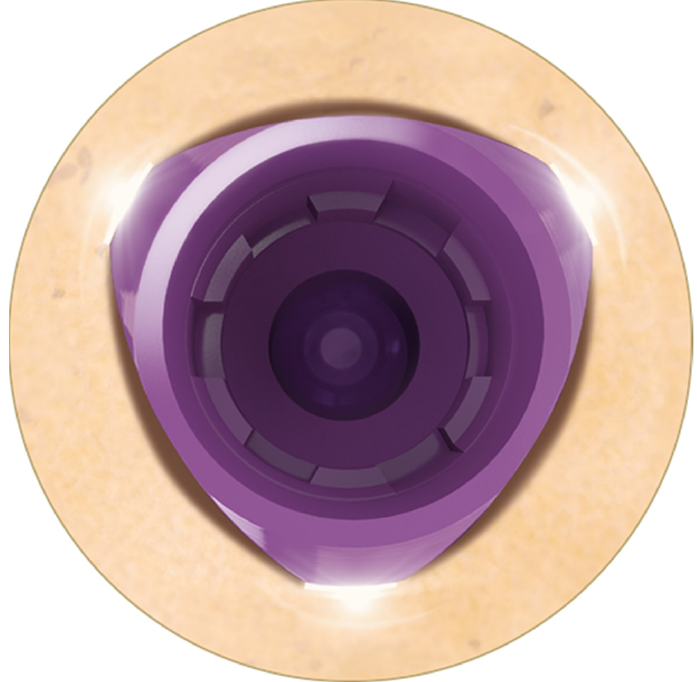
Figure 2. Occlusal view showing the flat area of the triangle oriented toward the buccal aspect of the ridge. The gap between the implant surface and surrounding bone can also be appreciated. Note the three areas of contact allowing primary stability.